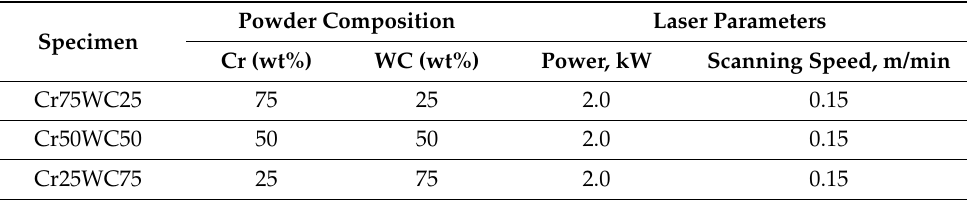
Table 2. Composition of Cr–WC powders and laser